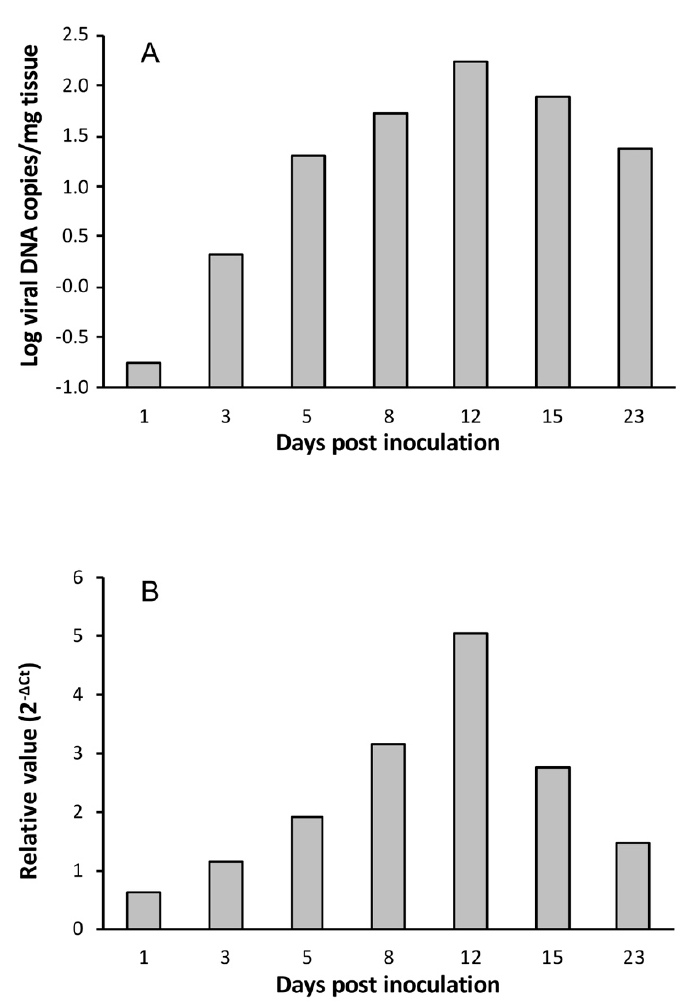
Figure 2. Temporal evolution of viral loads ( A ) and relative mcp gene expression values ( B ) in Artemia metanauplii inoculated with LCDV ATCC VR-342.